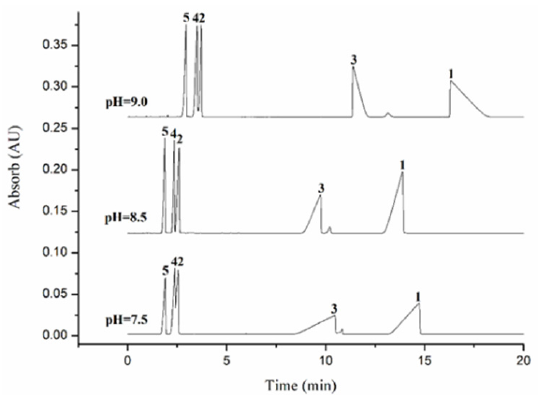
Figure 2. Electropherograms of five compounds at different pH values of buffer. Running buffer: 50 mM sodium borax-sodium dihydrogen phosphate system. Other conditions are the same as Figure 1.